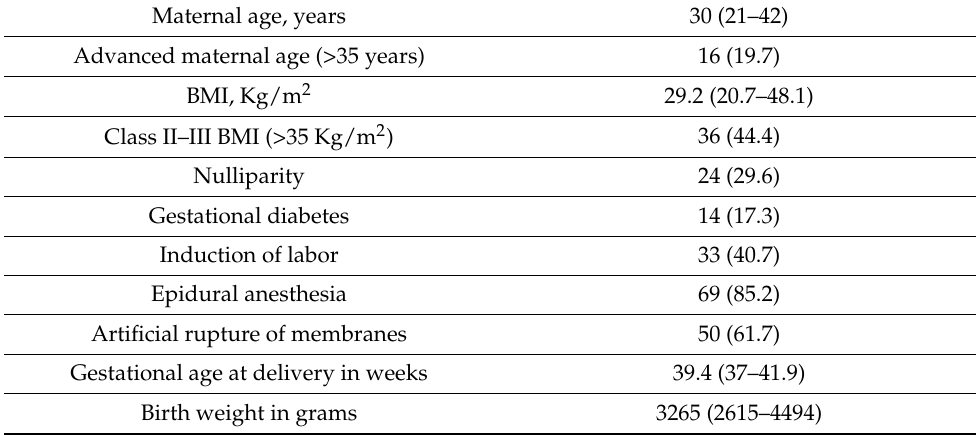
Table 1. Study cohort characteristics ( n =